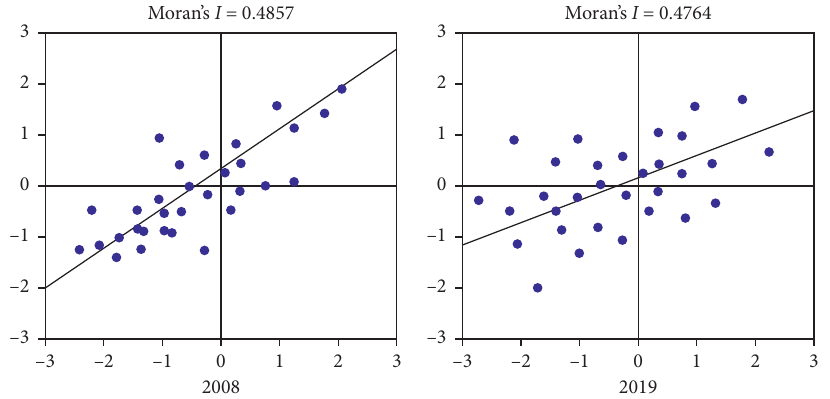
Figure 2: Moran index scatterplot of economic growth in 31 provinces of China in 2008 and 2019.